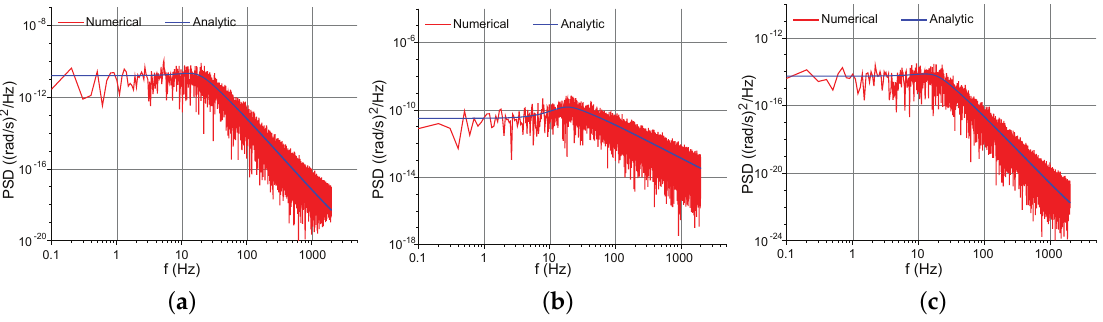
Figure 12. Numerically simulated and analytic PSD of the NER in the mode-matched force-rebalance sense channel. ( a ) The mechanical NER; ( b ) The pickoff electrical NER; ( c ) The feedback electrical NER. Comparisons of the PSD of the NER between different Q y , K a , and K f are demonstrated in Figure 13. For mode-matched gyroscopes working in the force-rebalance operation, the enhancement of Q y can significantly improve the mechanical and the pickoff electrical noise. Similar to mode-split gyroscopes in the force-rebalance operation, in low frequencies, K f only affects the PSD of the